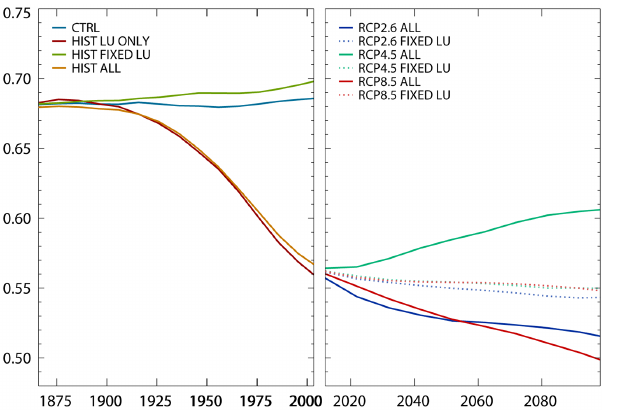
Figure 12. Global fractions of broadleaf tree simulated by HadGEM2-ES under historical forcings (left panel) and 3 of the 4 RCPs (right panel) with different combinations of climate and land use (LU) drivers. In the left panel, historical simulations were driven by; historical land use only, with no change in greenhouse gas con- centrations (HIST LU ONLY: red line); greenhouse gas changes but with land use fixed at the initial state in 1860 (HIST FIXED LU: green line); and a combination of the previous two (HIST ALL: yellow line). The control simulation with no external forcing is also shown (CTRL: blue line). In the right panel, dark lines (ALL) show simulations driven by greenhouse gas and land use changes for RCP2.6, RCP4.6 and RCP8.5, and faded lines (FIXED LU) show simulations driven with greenhouse gas changes but with land use fixed at the 2005 state.